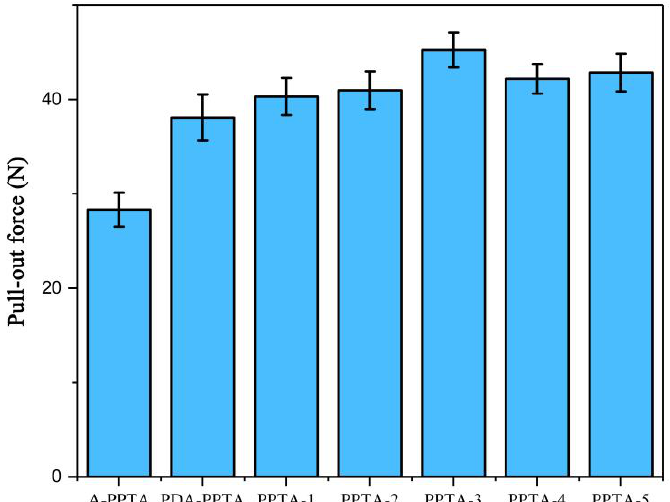
Figure 8. The pull-out results of PPTA fibers with rubber.